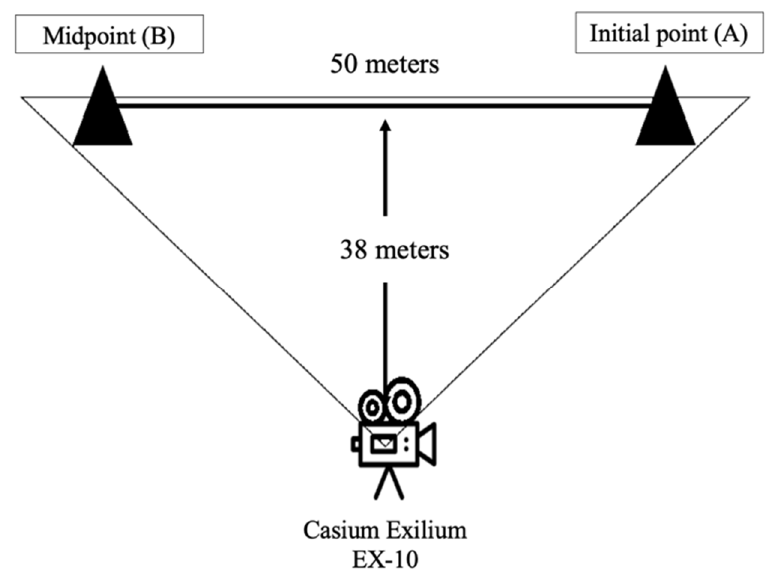
Figure 1. Laboratory condition protocol.